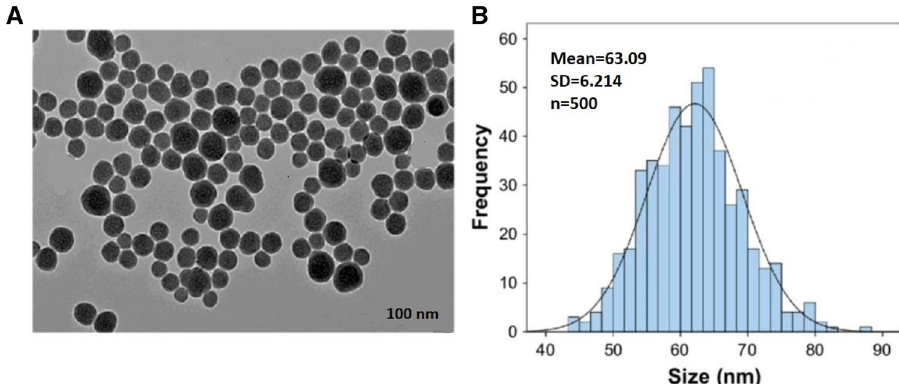
Figure 1. Si-NP characterization. TEM scans indicated well-dispersed spherical particles ( A ). ( B ) Normal distribution graph with 63.09 ± 6.21 nm mean diameter.